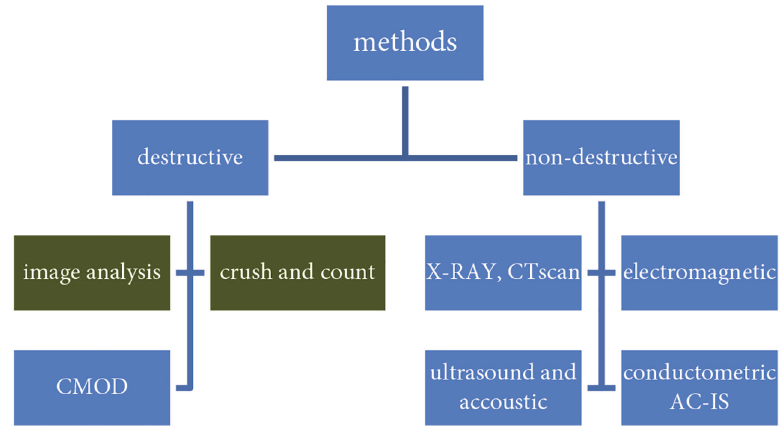
Figure 1. Fiber distribution and (or) orientation